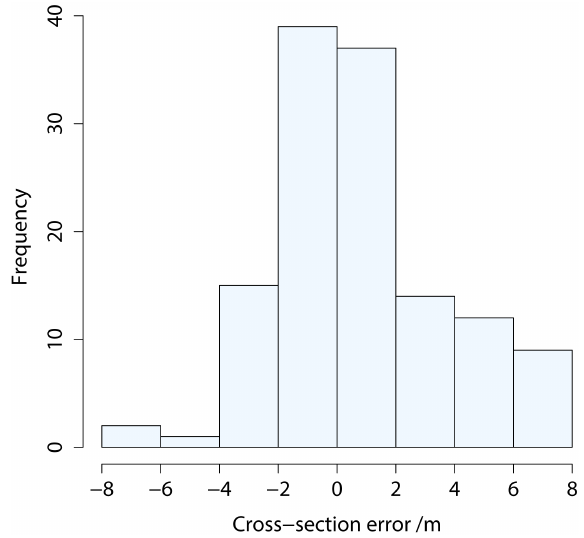
Figure 3. Histogram of cross-section errors.